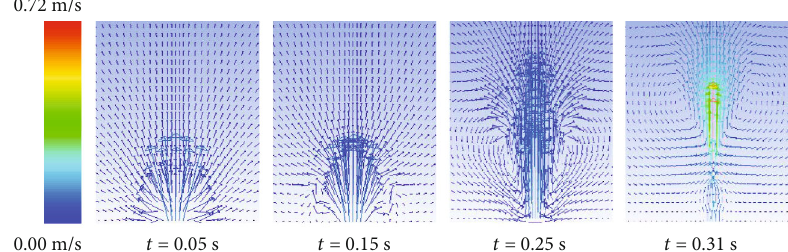
Figure 6: Diagram of the velocity vector for bubble formation and escape.